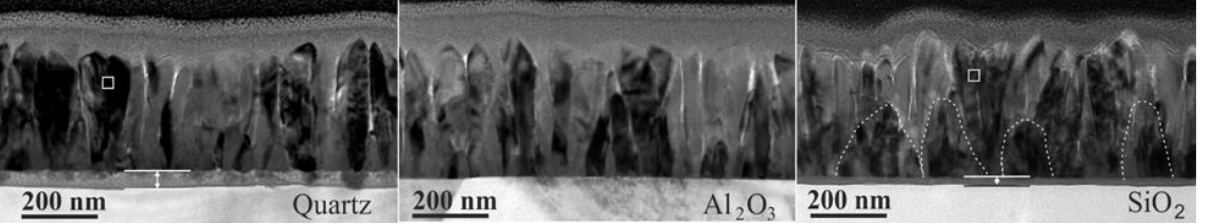
Figure 11. TEM images of nanostructured La-Sr-Mn-O films grown on quartz, polycrystalline Al 2 O 3 and amorphous SiO 2 /Si substrates. Reprinted from [68], copyright 2022 MDPI.